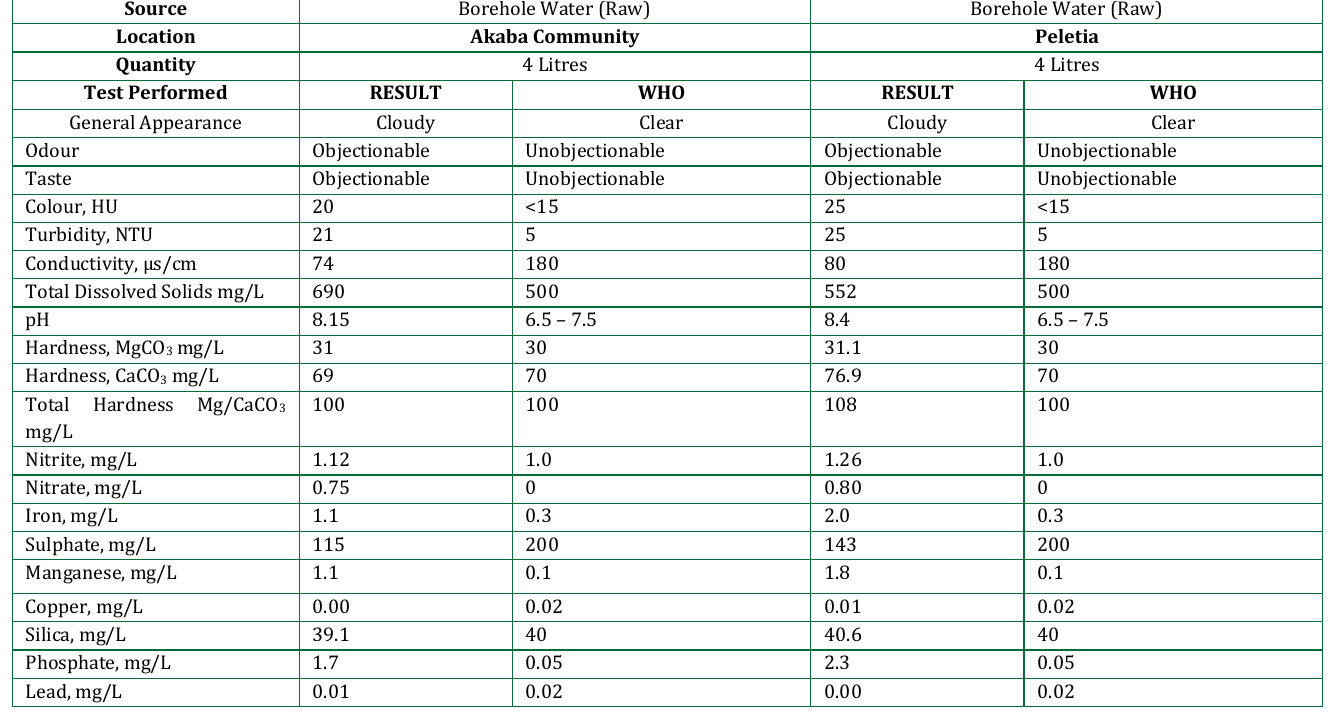
Table 3: Physicochemical Water Sample Analysis Results